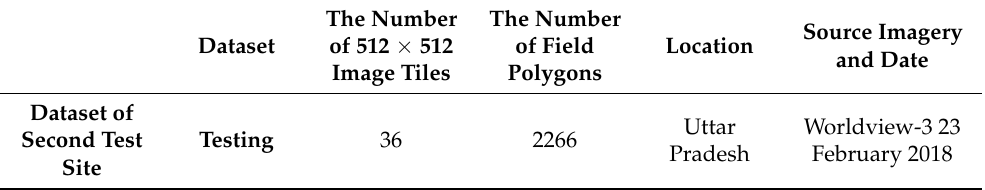
Table 2. Description of testing datasets that were used for evaluating the generalizability of models in Uttar